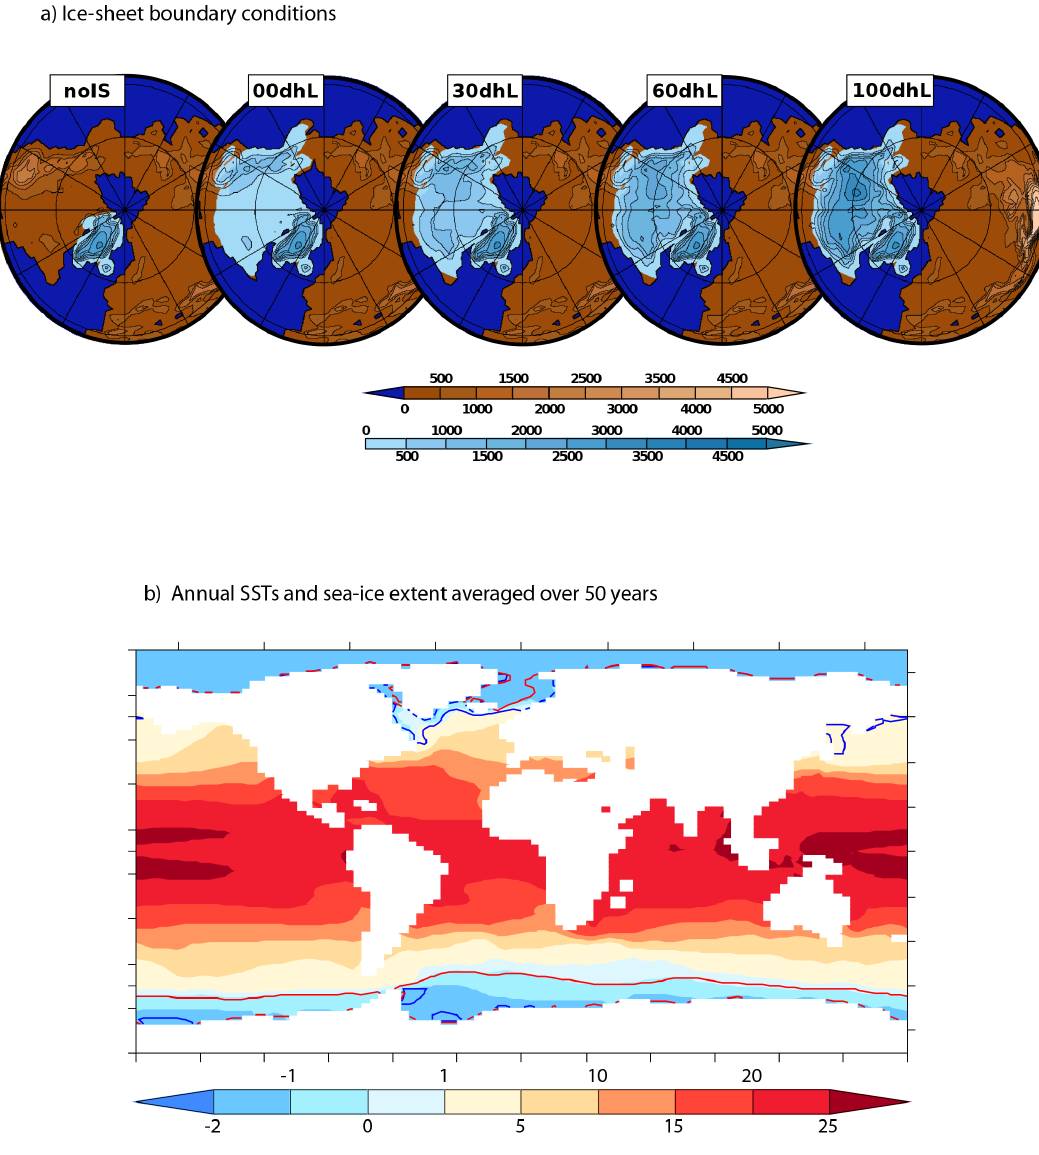
Figure 1. Ice-sheet and oceanic boundary conditions used for the LMDZ experiments. (a) Ice-sheet height (light blue scale) and land height (brown scale) given as boundary conditions for the 5 selected experiments out of 12. Dark blue–brown limits represent the sea-land mask, and brown–light blue limits represent the land-ice mask. (b) Averaged annual sea-surface temperature (shading) and sea-ice extent for boreal summer (red contours) and winter (blue contours) from the PMIP3 IPSL-CM5A-LR simulations. The averages are computed over 50 years which have been used to create the boundary conditions for the LMDZ